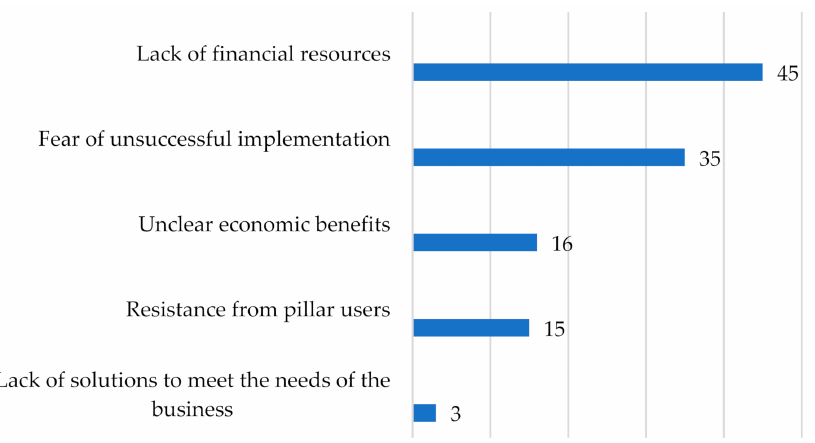
Figure 11. Barriers to implementing the pillars of Industry 4.0.